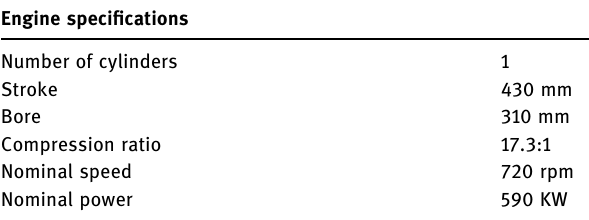
Table 2: Test at nominal speed, full load, and 1,650 bar CR pressure